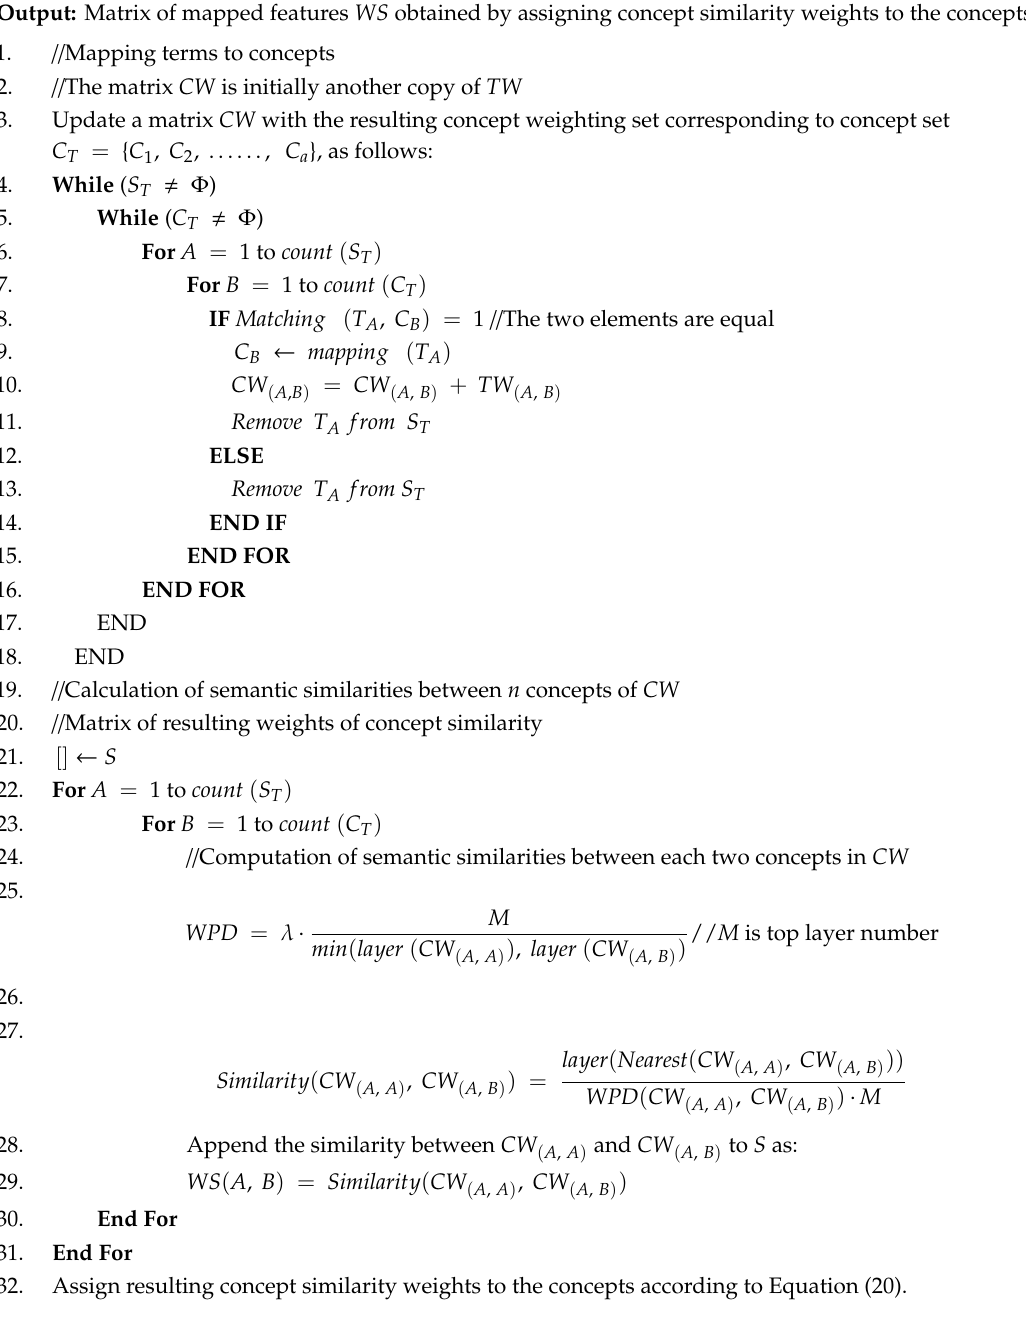
Algorithm 1: The Proposed Arabic Text Mining